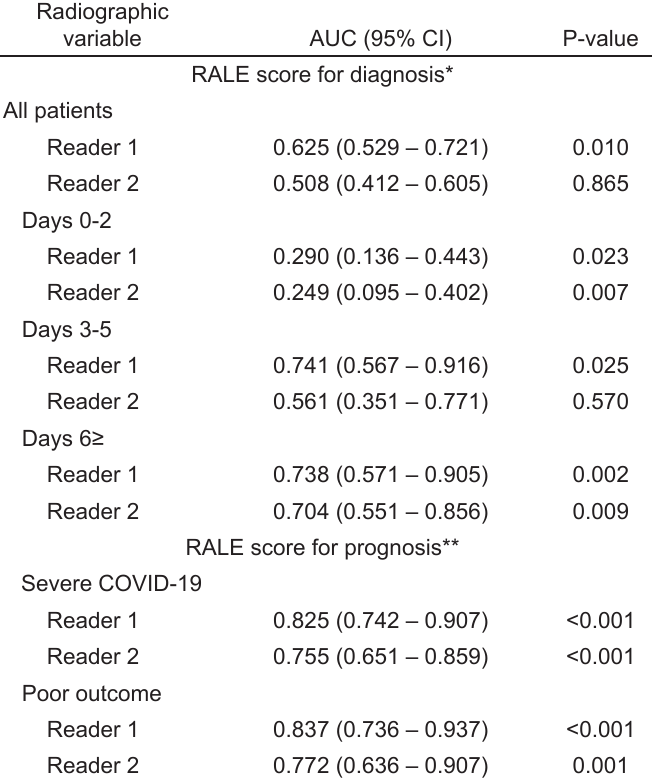
Table 3. Categorization by RALE score for diagnosis and prognosis of COVID-19 by receiver operator characteristics curve